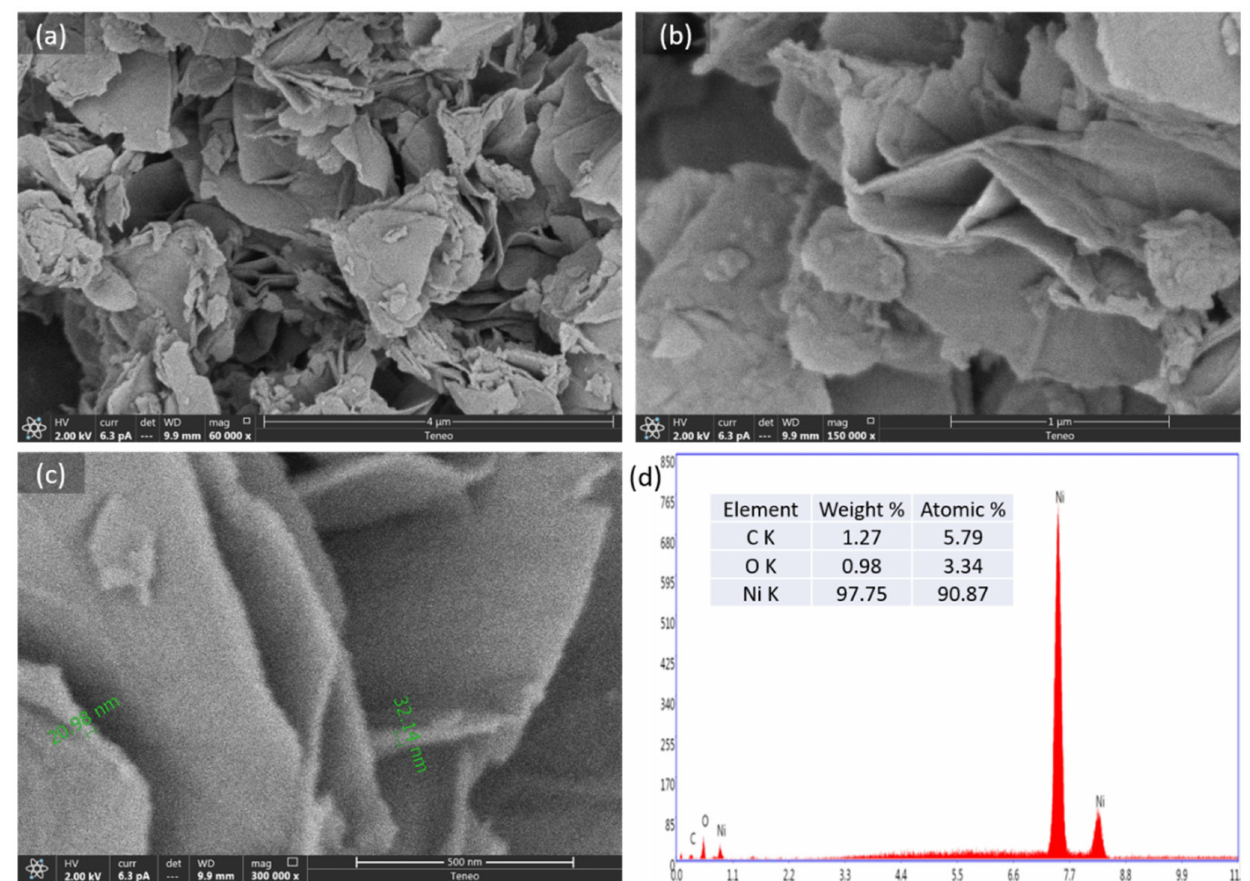
Figure 2. ( a – c ) SEM images of N.A.150C.10m at different magnifications and ( d ) the corresponding EDX spectrum with elemental weight and atomic